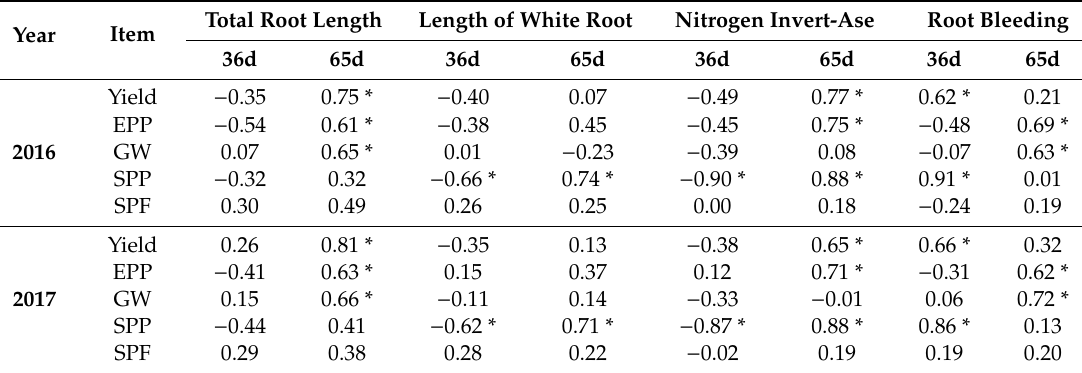
Table 5. Correlation analysis between root growth and rice